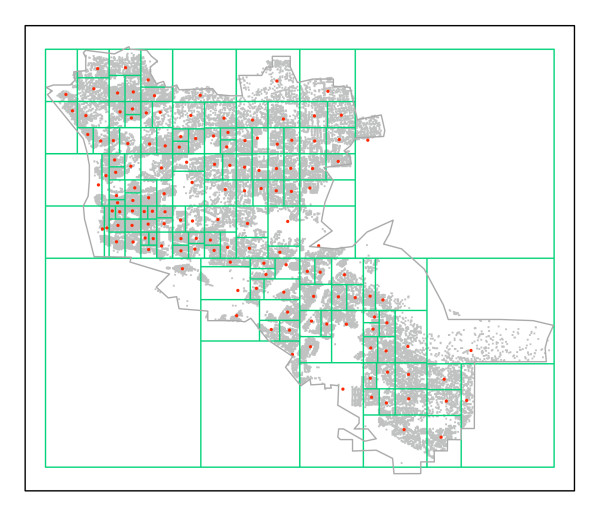
Set 1 Epiunt areal units, with maximum 1,000 births, for RC B. Population centroids for each unit are red. All located births are gray points.